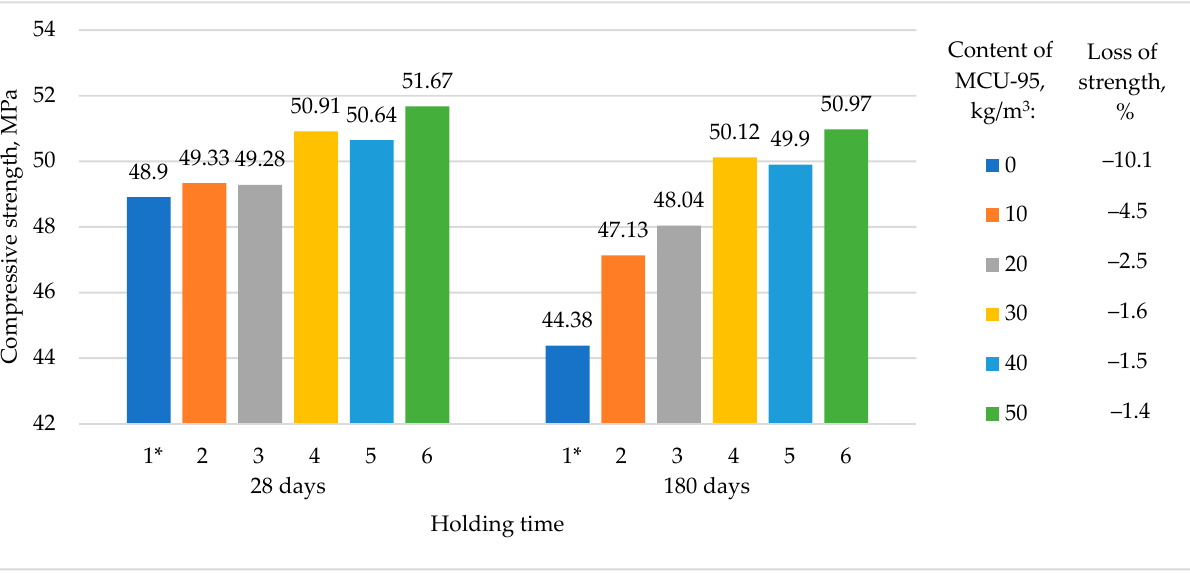
Figure 11. Decrease in the strength of RHC compositions after frost resistance tests. * Reference Figure 11. DecreaseinthestrengthofRHCcompositionsafterfrostresistancetests. composition.